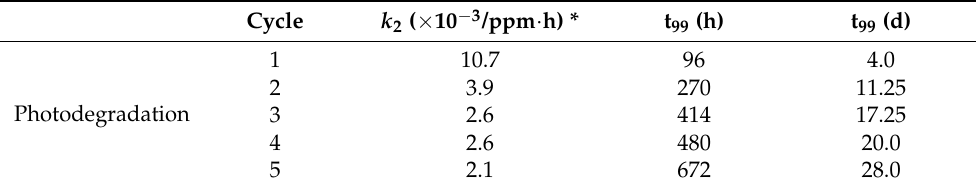
Figure 9. Photodegradation kinetics of MB under Blue LED: ( a ) MB removal plot, ( b ) normalized plot for pseudo-first-order, and ( c ) normalized plot for pseudo-second-order. Table 2. Photodegradation kinetics of MB removal under Blue